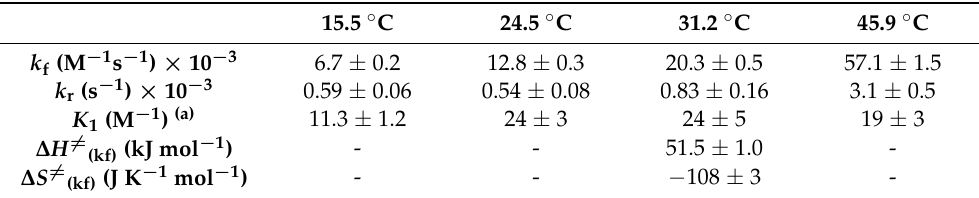
Table 6. Summary of the kinetic data for the substitution of triphenylphosphine oxide from cis